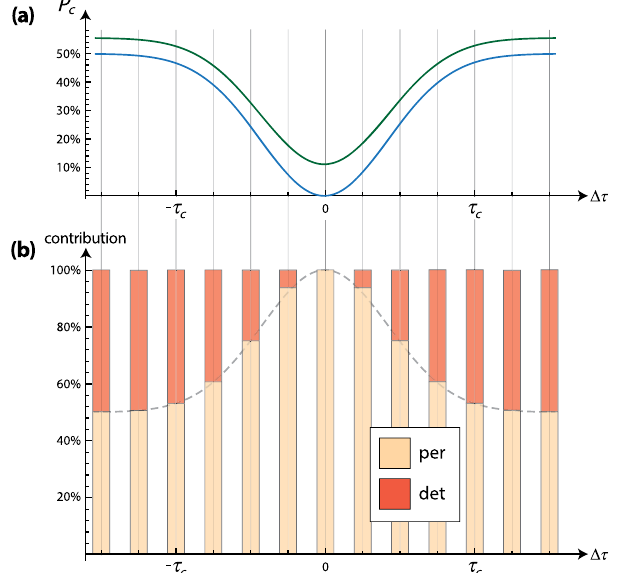
FIG. 2. Two-photon nonclassical interference. Two photons of temporal coherence τ enter a beam splitter through different c input ports. (a) The coincidence output probability P that they c leave in two different output ports is plotted with respect to a relative temporal delay Δ τ . This delay is used to tune the distinguishability of the otherwise identical photons. The blue curve shows P for a 50 = 50 beam splitter, and the green one for a c 67 = 33 beam splitter. (b) Contribution of the permanent (per) and determinant (det) to the output probability for a coincident detection event P . It is the same for both beam splitters because c this description is independent of the interferometer. In the case for zero delay ( Δ τ ¼ 0 ), only the permanent contributes. By explicitly calculating the permanent, which is zero for a 50 = 50 beam splitter, the vanishing coincidence probability P (a) for c zero delay is